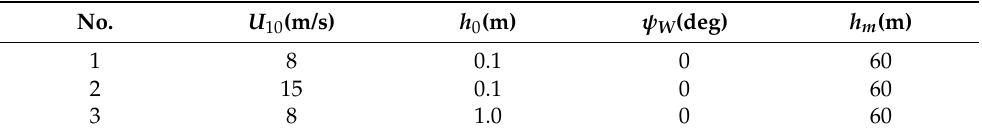
Table 1. Simulated wind